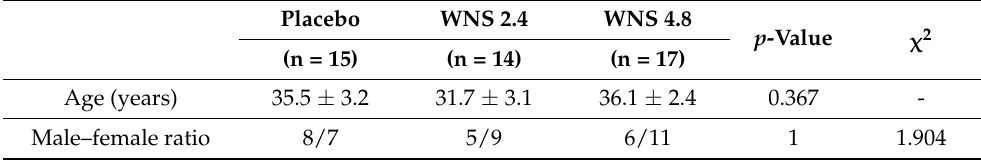
Table 1. Characteristics of randomized